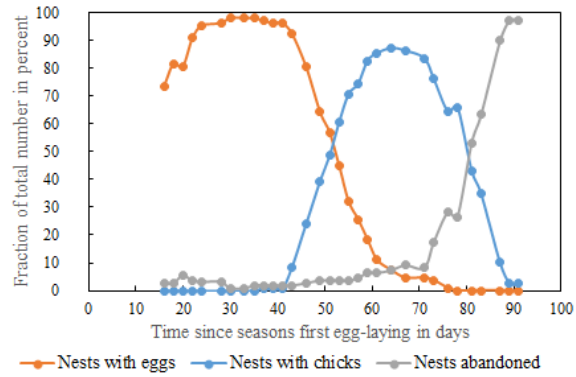
Figure 7. Season 2016/17: breeding phenology of gentoo penguins